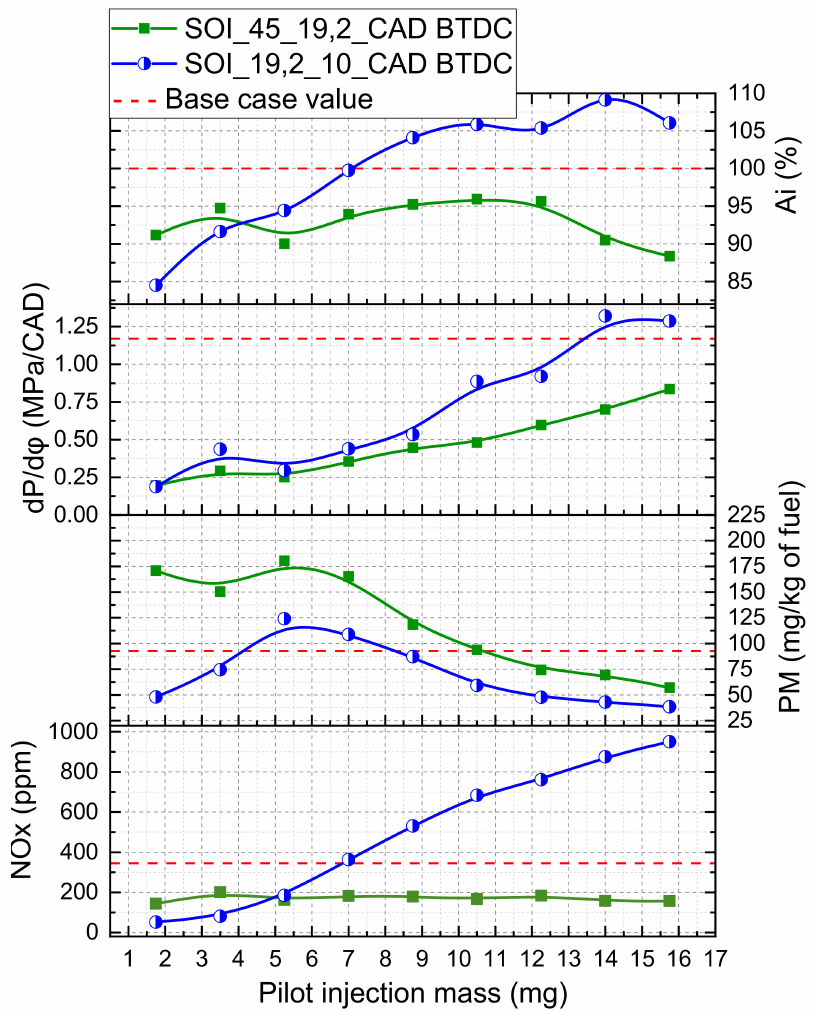
Figure 13. The pilot injection fuel mass variable influence on combustion process and